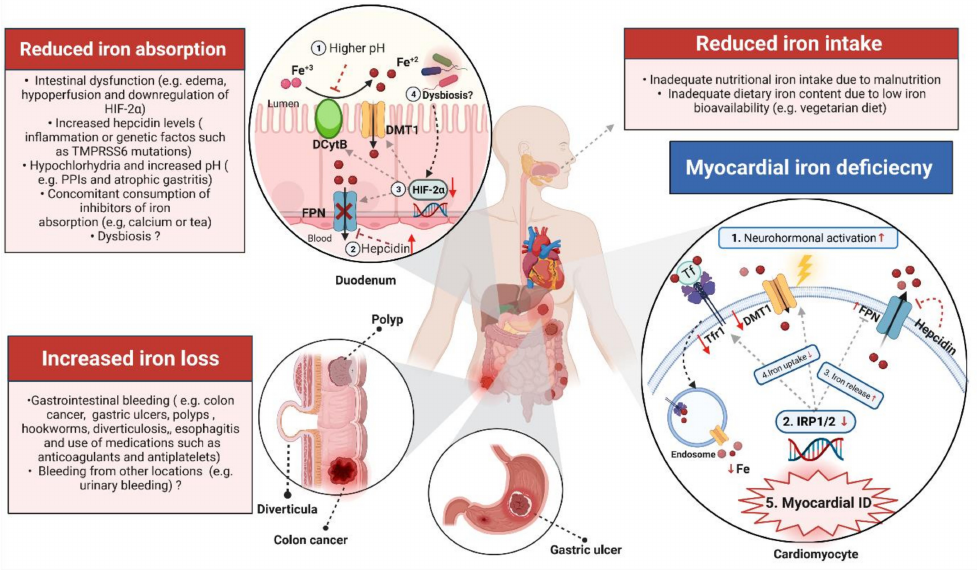
Figure 2. Summary of the current understanding of the mechanisms underlying iron deficiency in heart failure. This step is essential to enable iron uptake by the divalent metal transporter